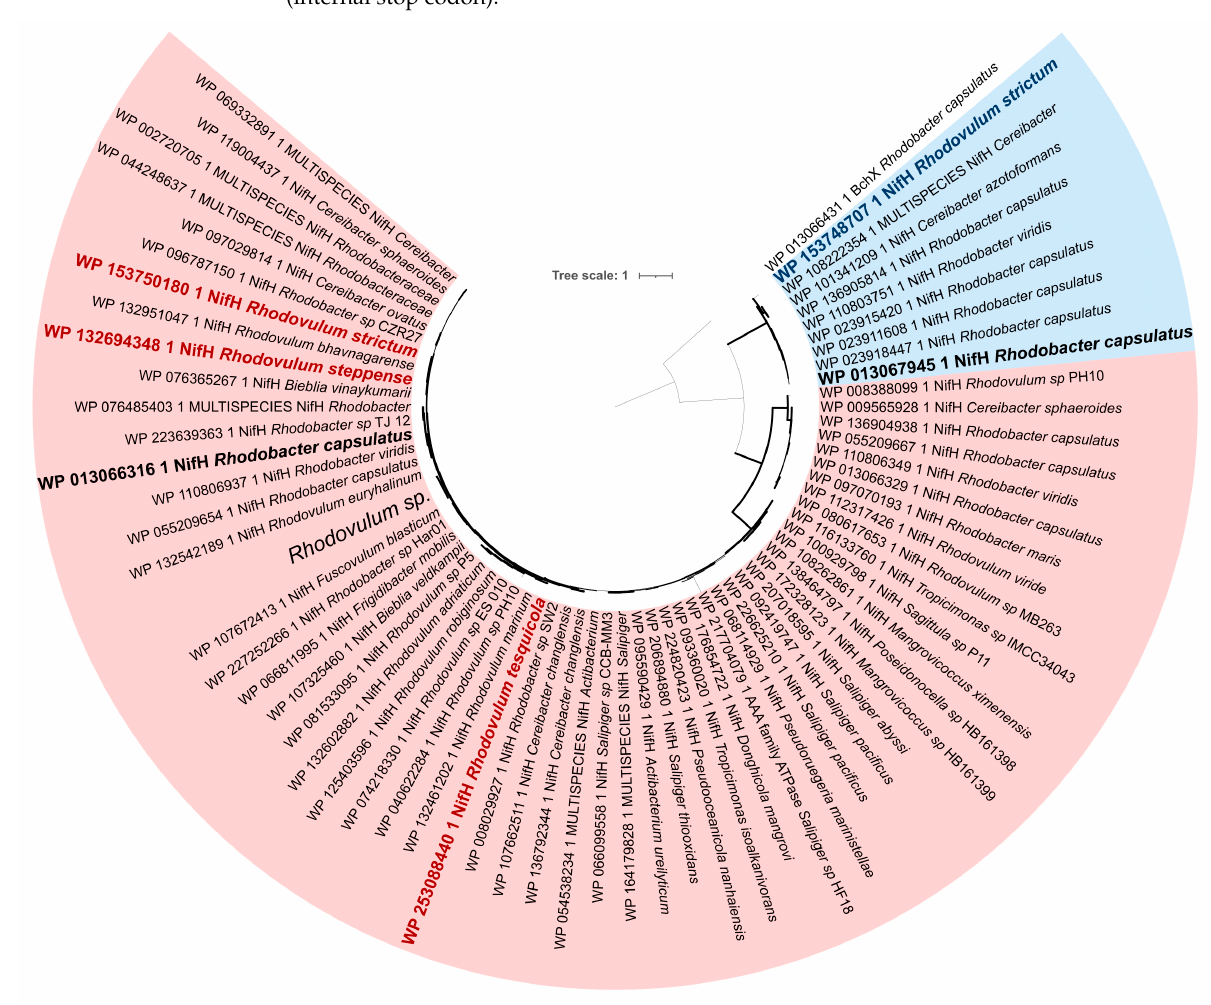
Figure 6. Phylogeny of nifH gene across Rhodobacterales . The tree includes nifH homologues missing in R. steppense and R. tesquicola but found in R. strictum and Rhodobacter capsulatus strain SB1003 (blue background) and nifH homologues appearing in all three Rhodovulum strains (red background). Ultrafast bootstrap values are displayed as branch width. The tree is scaled by evolutionary distance (count of substitutions per site).